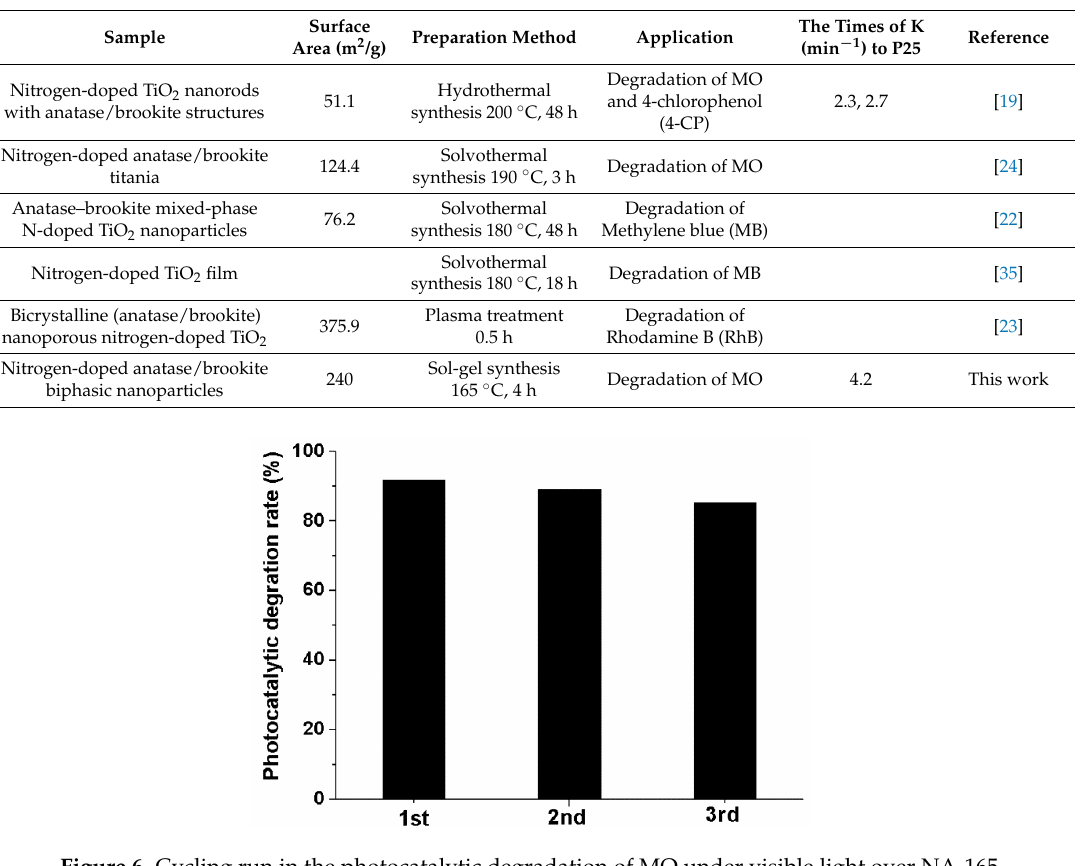
Figure 6. Cycling run in the photocatalytic degradation of MO under visible light over NA ‐ 165.